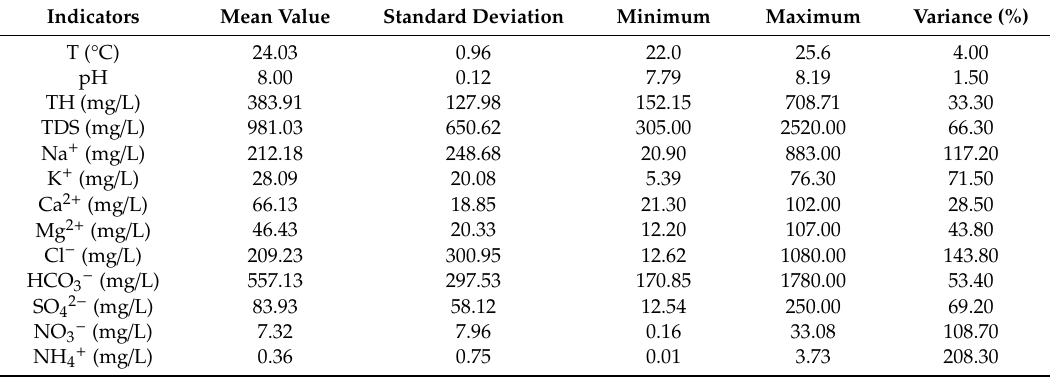
Table 1. Statistical summaries of hydrochemical elements of shallow groundwater in the study